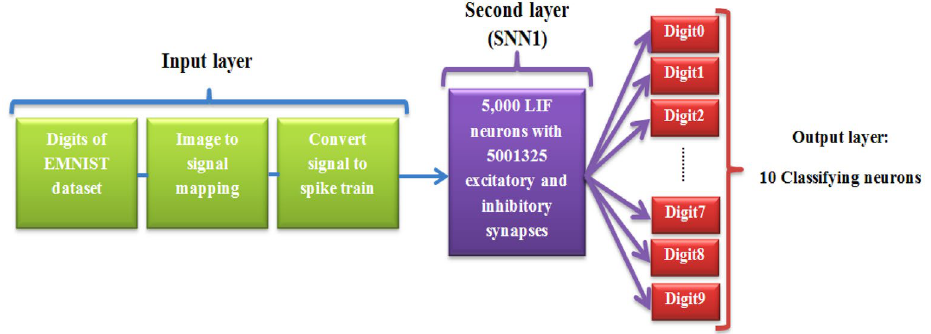
Figure 3. The general schematic of the pattern recognition network based on SNN1 (digit recognition